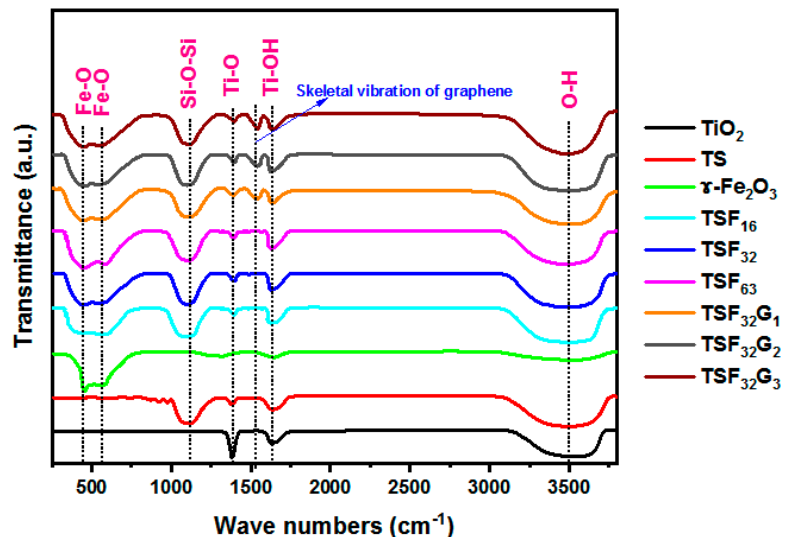
Figure 5. FT-IR spectra of the TiO 2 , TS, γ -Fe 2 O 3 , TSF, and TSF 32 G coated films in the wavenumber range from 300 to 4000 cm − 1 .